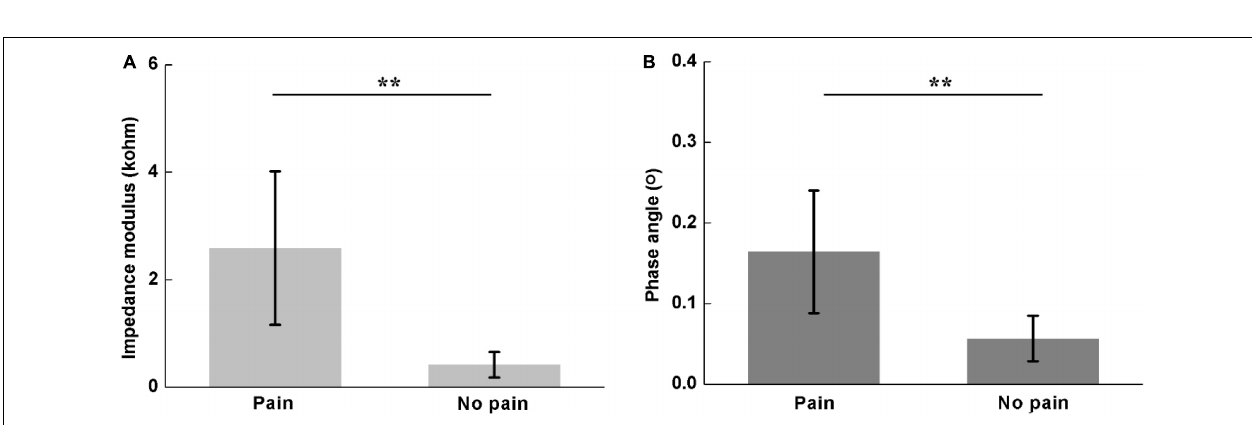
FIGURE 5 | Comparisons of the sum of lumbar muscle impedance on both sides for different LBP scales, including (A) impedance modulus (Scale 1: 3.48 ± 0.72; Scale 2: 5.22 ± 1.67; Scale 3: 6.48 ± 1.46; Scale 4: 7.45 ± 0.98) and (B) phase angle (Scale 1: 1.06 ± 0.19; Scale 2: 1.10 ± 0.13; Scale 3: 1.04 ± 0.14; Scale 4: 0.76 ± 0.23). Scale 1–4 of LBP represent no pain, mild dysfunction, moderate dysfunction and severe dysfunction, respectively. *denotes P < 0.05 and **denotes P < 0.01.